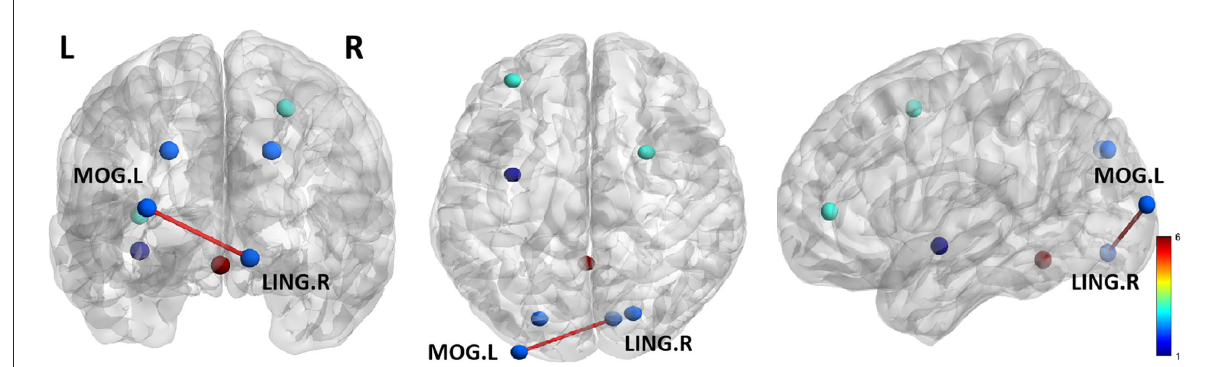
FIGURE2 The two groups significantly differ in functional connectivity (FC) of ROI regions. Compared with HCs, the ANI patients showed significantly greater FC between the LING. R and MOG.L. Lines represent FC between each pair of defined ROI regions, with significant group differences between the two groups. The size of the lines represents the absolute value of the T values. LING. R, right lingual gyrus; MOG. L, left middle occipital